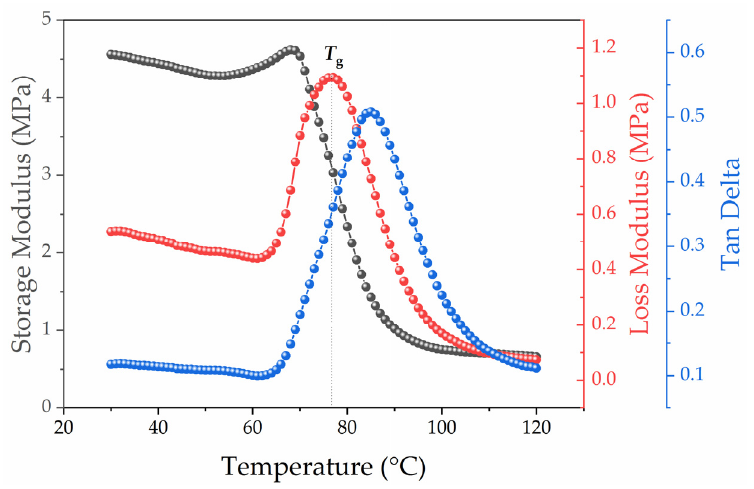
Figure 2. DMA of unfilled polyurethane sample